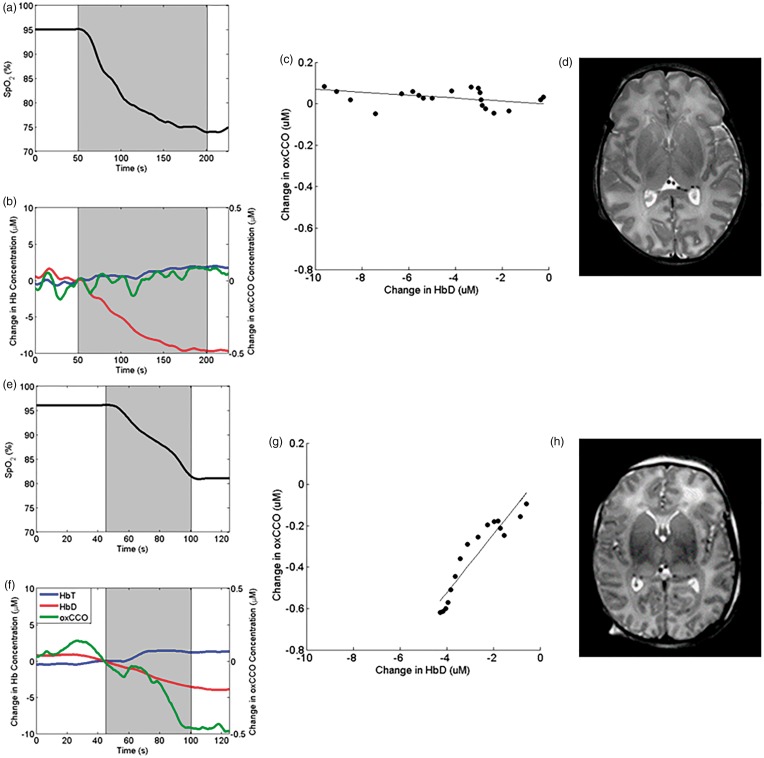
Examples of broadband NIRS and MR data from two infants with
different HI injury severities. (a–d) Neonate 021 with favourable
outcome: (a) pulse oximeter recording of SpO2 during
desaturation event (grey). (b) NIRS recording of HbD, HbT and oxCCO
during same desaturation event (grey) as in (a). Note that oxCCO is
plotted on the right axis. (c) Change in oxCCO against HbD during
desaturation period from (a) and (b) showing a gradient of −0.01.
(d) T2 weighted MRI on day 7 revealed high signal intensity in the
white matter (WM) with normal deep grey matter (DGM). Lac/NAA was
0.2. (e–h) Neonate 007 with unfavourable outcome. (e) Pulse oximeter
recording of SpO2 during desaturation event (grey). (f)
NIRS recording of HbD, HbT and oxCCO during same desaturation event
(grey) as in (e). Note that oxCCO is plotted on the right axis. (g)
Change in oxCCO against HbD during desaturation period from (e) and
(f) showing a gradient of 0.14. (h) T2 weighted MRI on day 5
revealed widespread signal intensities both in WM and DGM. Lac/NAA
was 1.32.